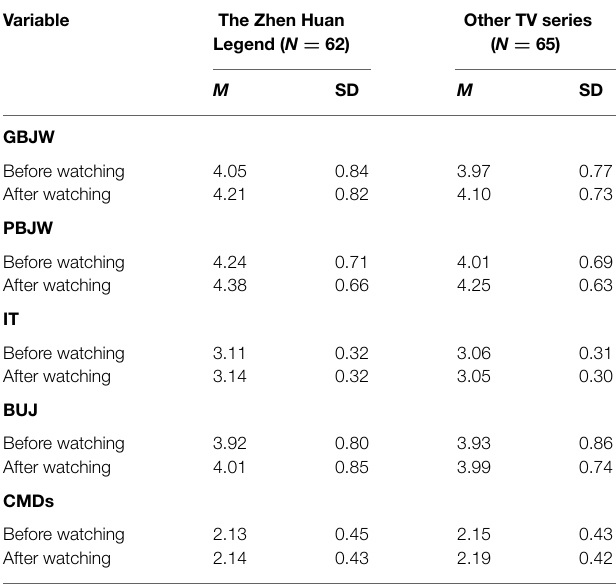
TABLE 1 | Mean scores and standard deviations for GBJW, PBJW, IT, BUJ, CMDs by the testing time and the type of TV series watched.